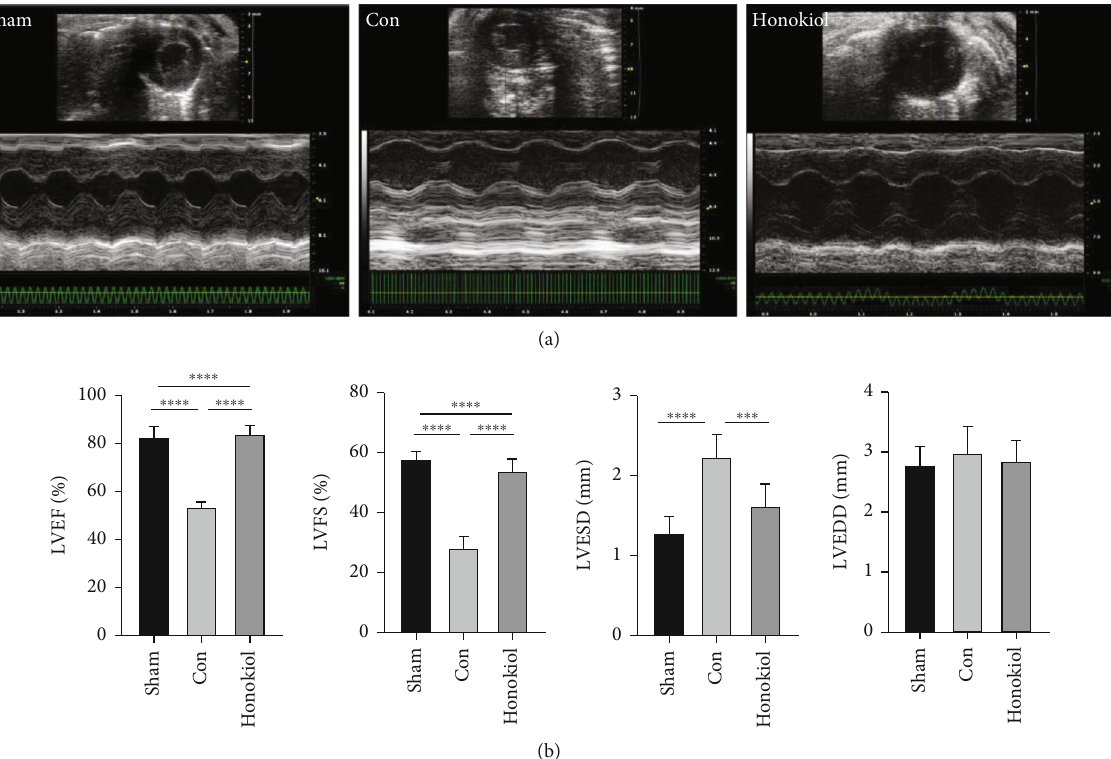
Figure 3: Echocardiography of MI/RI mice. (a) Echocardiograms of the mice. (b) Both LVFS and LVEF were elevated, while LVESD was lower in the Honokiol cohort as opposed to the Con cohort. No di ff erence was observed in the LVEDD in all cohorts. N = 10 for each cohort. Data are articulated as mean ± SEM . ∗∗∗ p < 0 : 001 . ∗∗∗ ∗ p < 0 : 0001 .